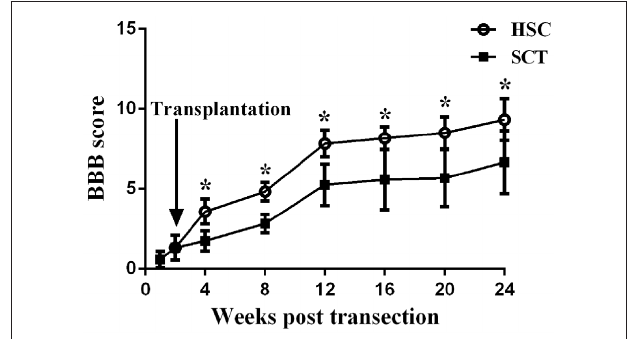
FIGURE 5 | HSCs transplantation improved the neural behavior in rats subjected to SCT. BBB score of the sham group was 21. There was a significant decrease of BBB score at week 1–24 after operation in SCT and HSC group ( n = 15/group). HSC transplantation group displayed a significantly improved scores compared with SCT group beginning at week 2–22 after transplantation. Three independent experiments were performed and the data are presented as the mean ± SD ( n = 15). Student’s t test was used to analyze the data. ∗ P < 0.05 vs. SCT. Arrow indicates the HSC transplantation